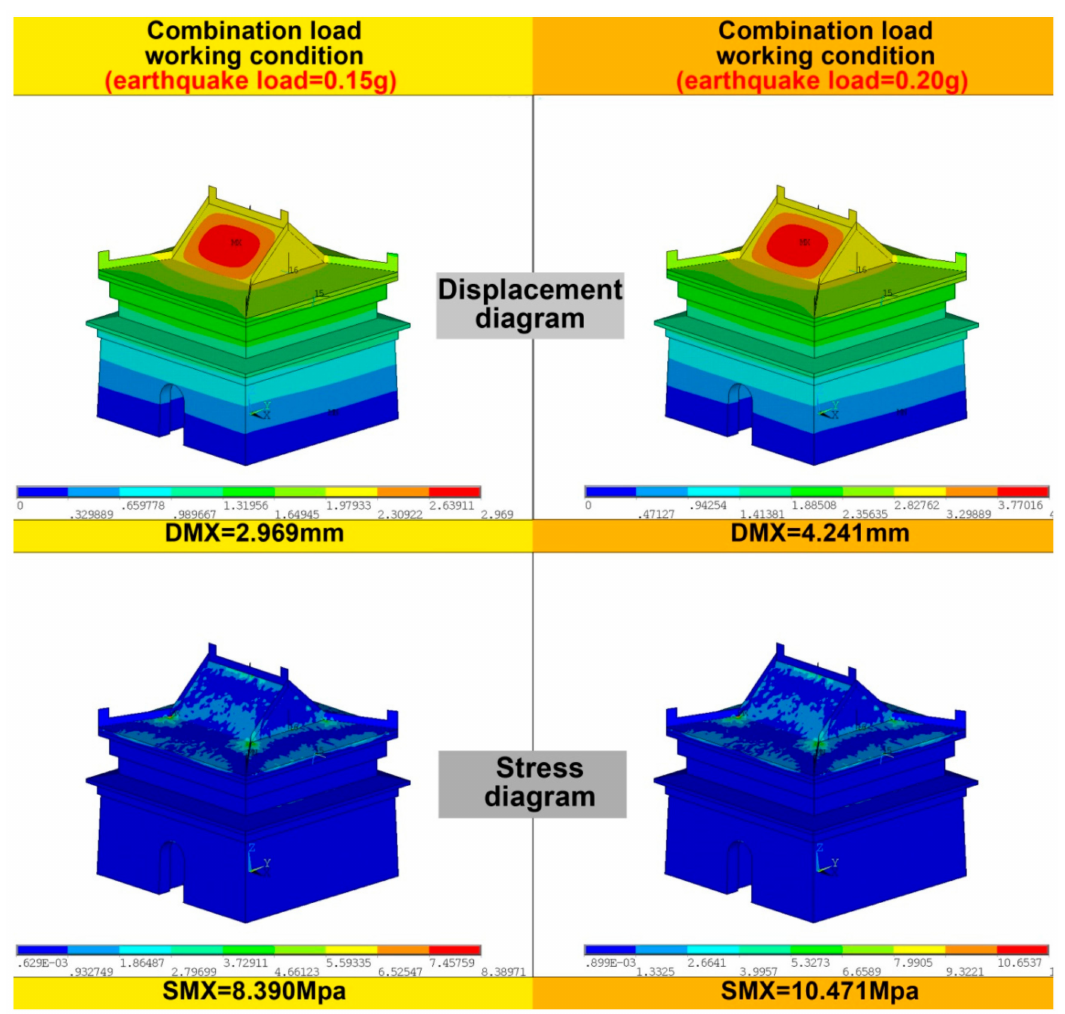
Figure 20. Displacement diagram and stress diagram of the Limestone Hall under ideal status with earthquake accelerations of 0.15 g and 0.2